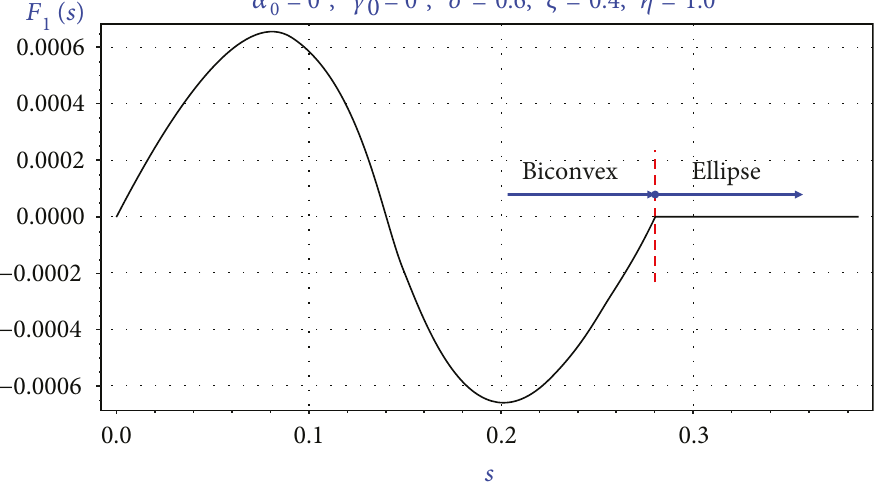
Figure 16: Primary warping function of Model A at ξ = 0 7716 .